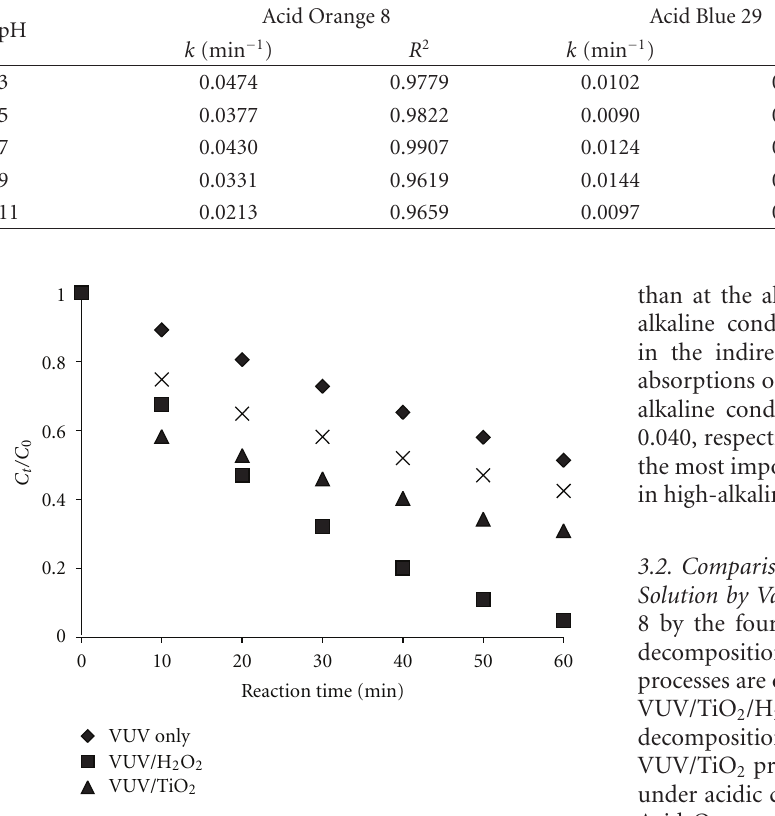
Figure 4: The degradation of acid Orange 8 under VUV irradiation at acidic condition, [Dye] = 0.0523 mM, [H 2 O 2 ] = 100 mg/L, [TiO 2 ] = 0.5g/L, VUV intensity = 110 V, pH 3, 25 ◦ C, 400 rpm.